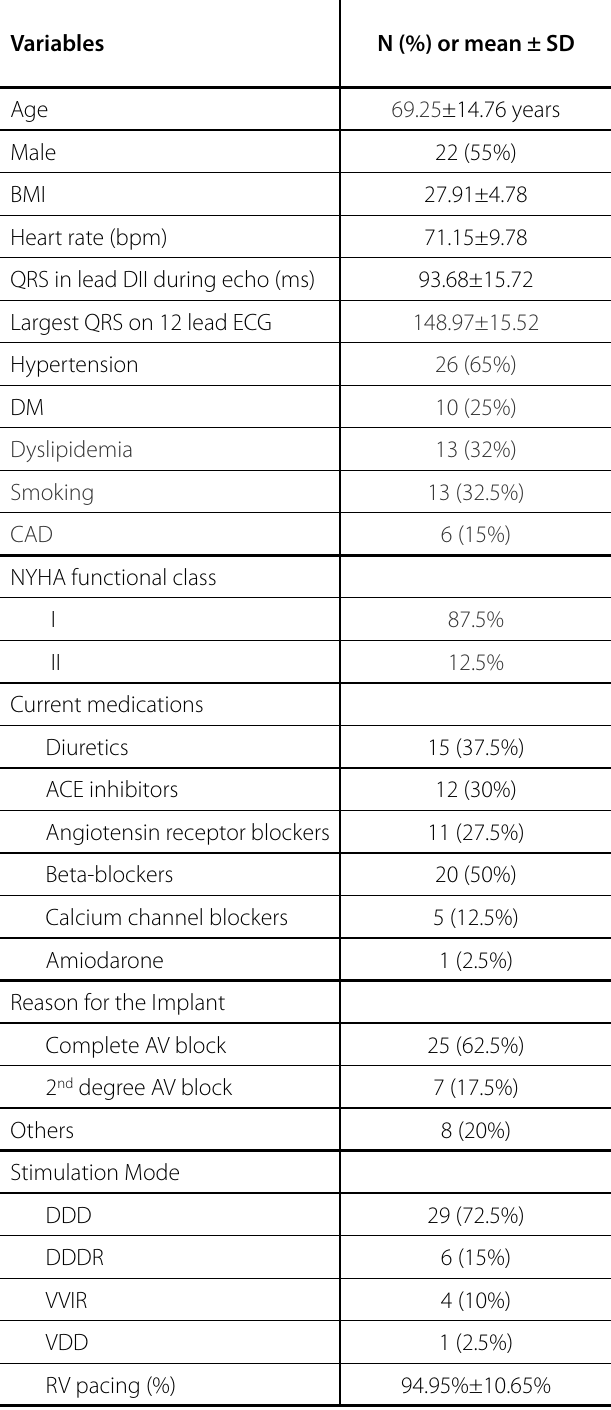
Table 2. Echocardiographic measurements of ventricular synchrony, in milliseconds.